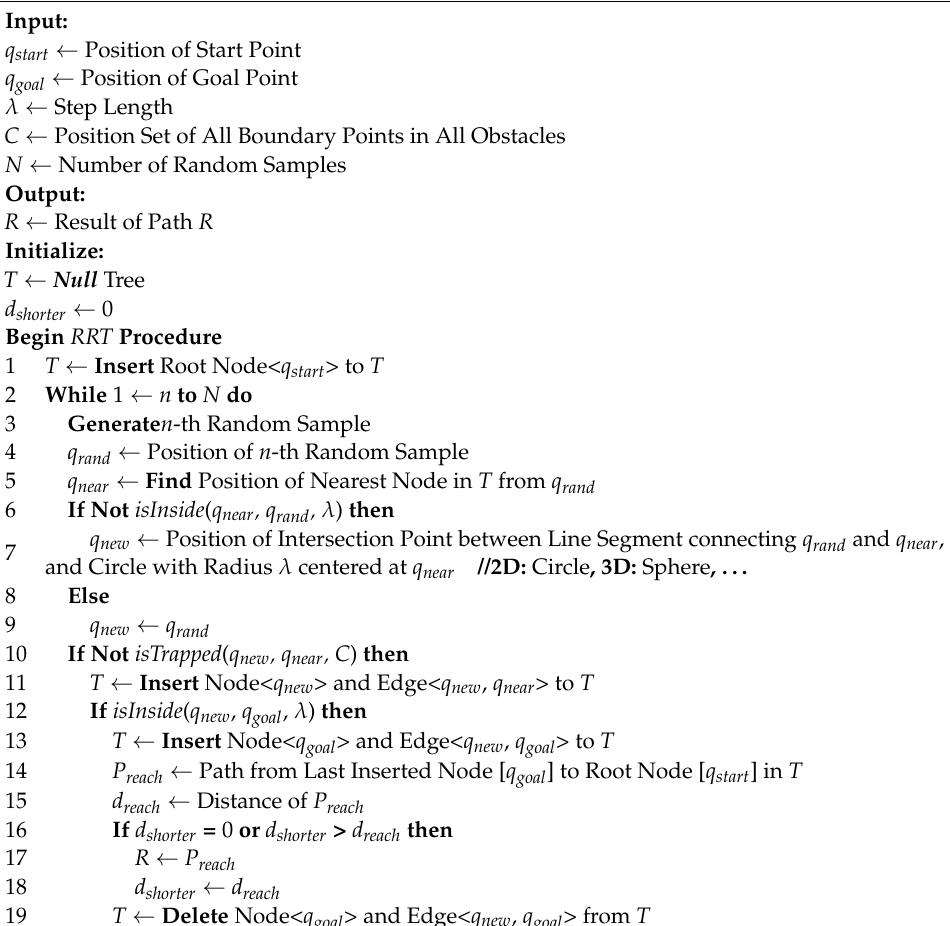
Algorithm A1 Pseudocode of the RRT